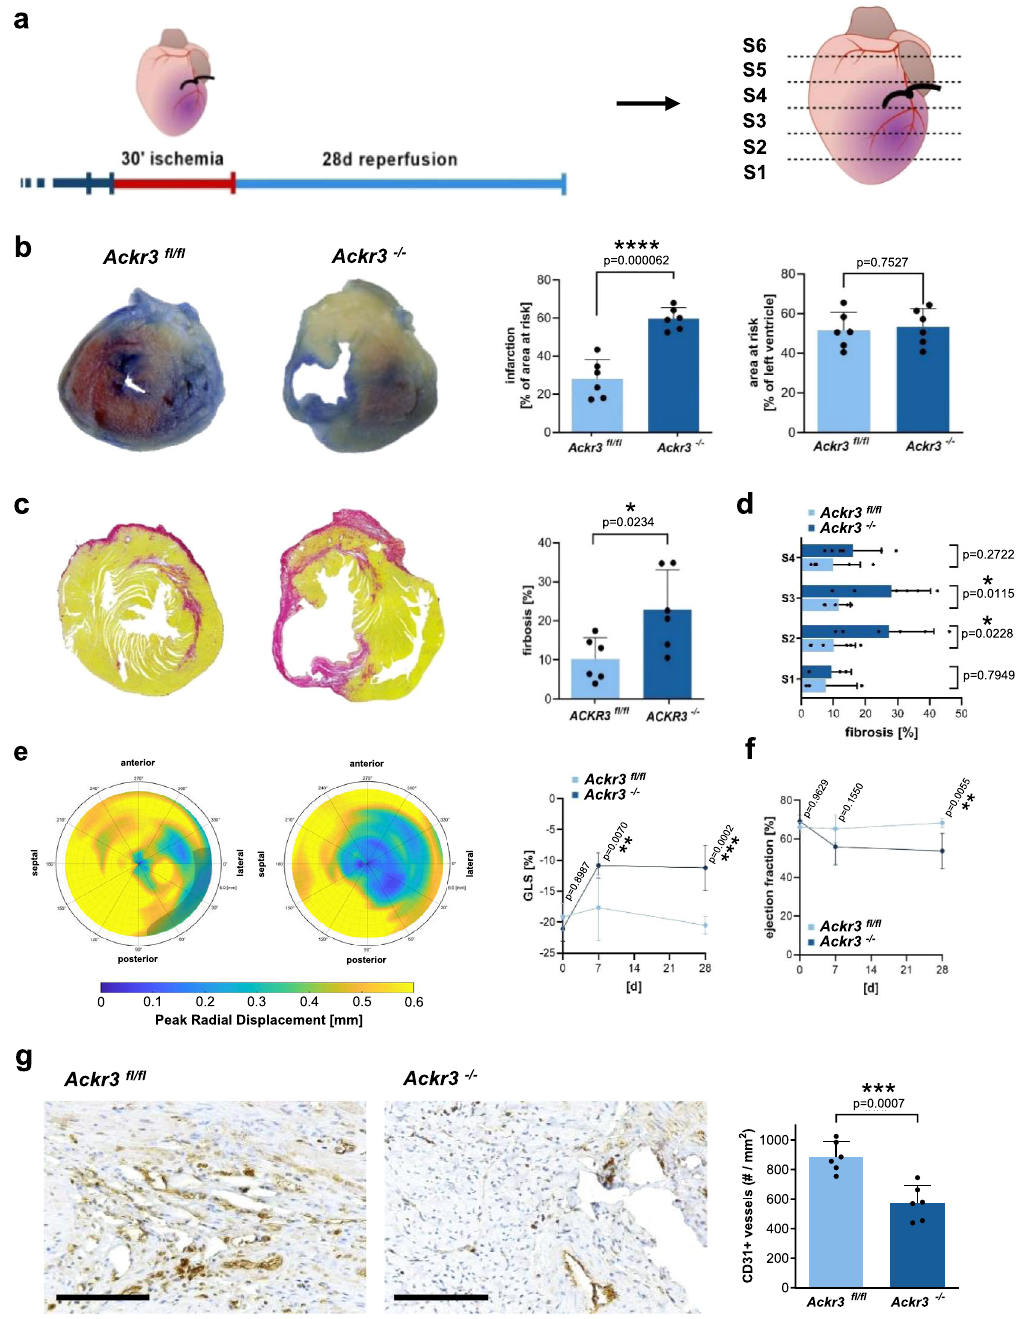
Fig. 6 30 min ischemia and 28-day reperfusion of the heart in Ackr3 − / − versus Ackr3 fl / fl mice. a Schematic drawing of the timeline and heart sectioning for long-term functional outcome of MI and reperfusion. b Representative TTC/Evans blue staining of the heart section. Statistical analysis of the area at risk of the left ventricle in percent and the infraction of the area at risk in percent, n = 6; Plotted: mean ± S.D.; Statistics: Student ’ s t test; 95% con fi dence interval. c Representative pictures of Sirius Red staining of the fi brosis within the heart section 4 and statistical analysis of the fi brosis in the whole heart, n = 6; Plotted: mean ± S.D.; Statistics: Student ’ s t test; 95% con fi dence interval. d Statistical analysis of the fi brosis separated by heart sections S1 to S4. S1: Ackr3 fl / fl : n = 3, Ackr3 − / − : n = 3; S2: Ackr3 fl / fl : n = 6, Ackr3 − / − : n = 6; S3: Ackr3 fl / fl : n = 6, Ackr3 − / − : n = 6; S4: Ackr3 fl / fl : n = 5, Ackr3 − / − : n = 6. Plotted: mean ± S.D.; Statistics: two-tailed Student ’ s t test; 95% con fi dence interval. e Strain analysis of the heart in Ackr3 − / − versus Ackr3 fl / fl mice, n = 6; Plotted: mean ± S.D.; Statistics: two-tailed Student ’ s t test; 95% con fi dence interval. f Statistical analysis of the ejection fraction of the heart over time in Ackr3 − / − versus Ackr3 fl / fl mice, n = 6; Plotted: mean ± S.D.; Statistics: two-tailed Student ’ s t test; 95% con fi dence interval. g Representative images of CD31 staining and statistical analysis CD31 + vessels in Ackr3 − / − versus Ackr3 fl / fl mice. Scale bar = 50 µ m, n = 6; Plotted: mean ± S.D.; Statistics: two-tailed Student ’ s t test; 95% con fi dence